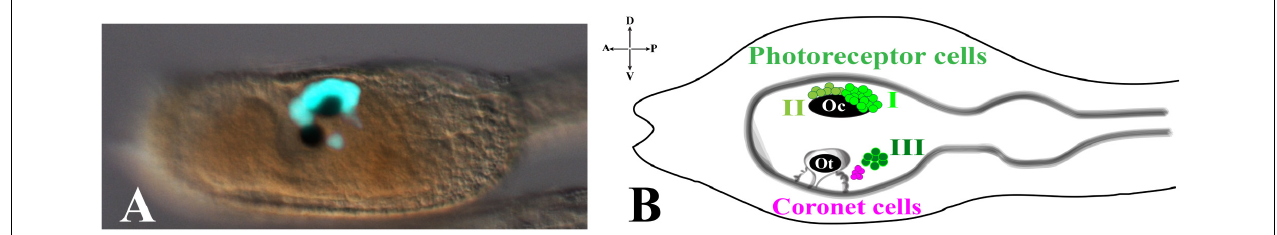
FIGURE 1 | Pigmented organs in the sensory vesicle. (A) pArr > eGFP expression in photoreceptor territories of Ciona larval trunk (Yoshida et al., 2004) (photo from our lab). (B) Schematic representation of larval trunk. Ocellus (Oc) and otolith (Ot) pigment cells. Photoreceptor cell types I, II are associated with ocellus pigment cell, while photoreceptor cell type III is in close proximity to otolith pigment cell and coronet cells.